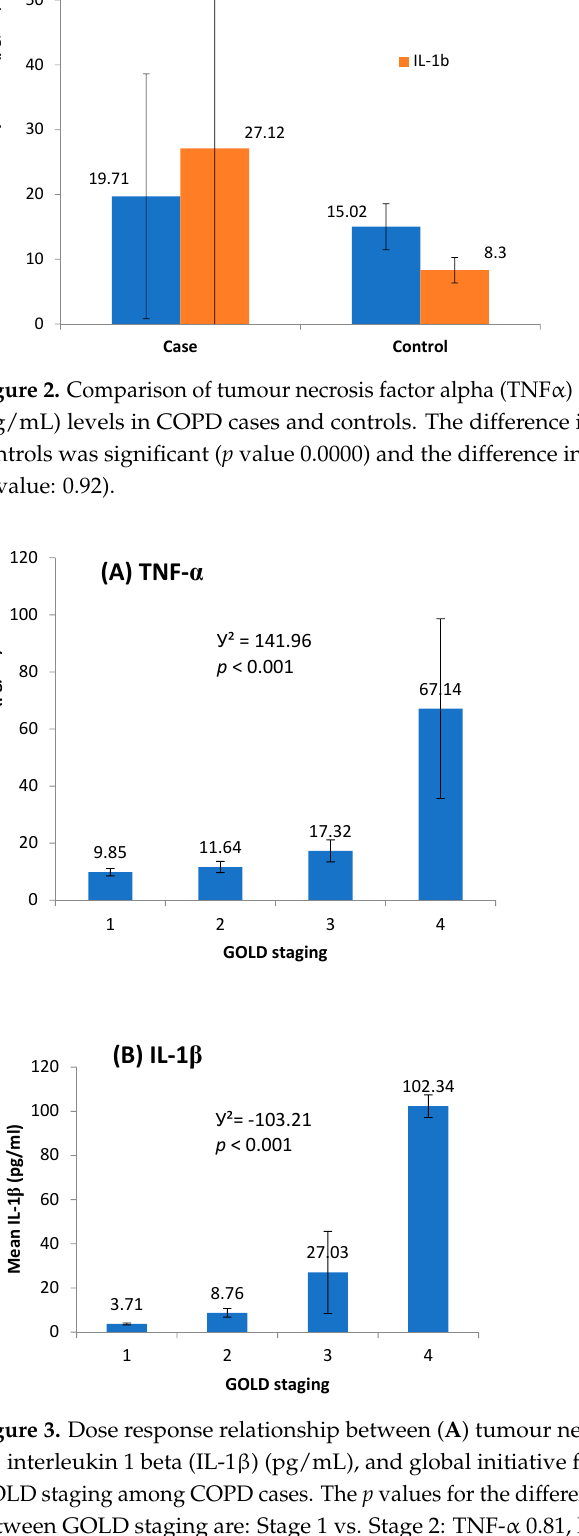
5 of 17 Figure 1. Flowchart of screening and inclusion of cohort. 6 MWT: six minute walk test, BMS: Bio- mass Smoke, COPD: Chronic obstructive pulmonary disease, TS: Tobacco smoke.